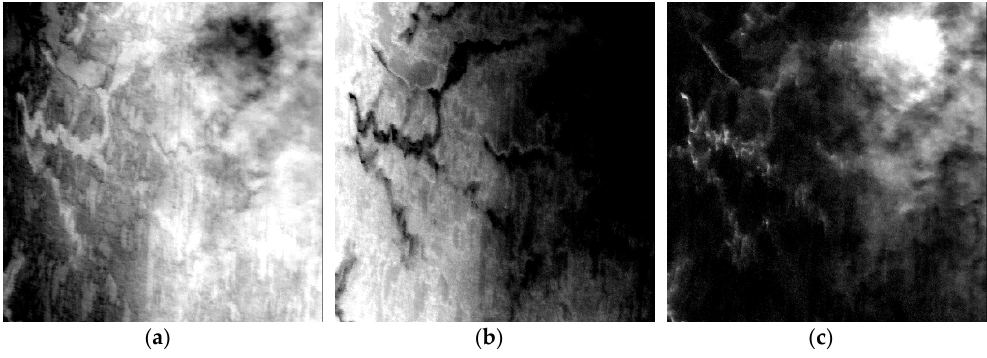
Figure 18. The abundance maps using DSPP+MVSA. ( a ) oil; ( b ) water; ( c ) cloud.